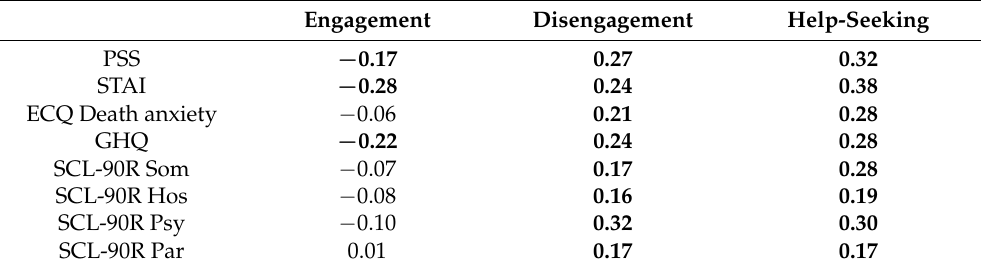
Table 5. Semi-partial correlation coefficients for the three coping styles with psychological symptoms while controlling for all other psychological and socio-demographic